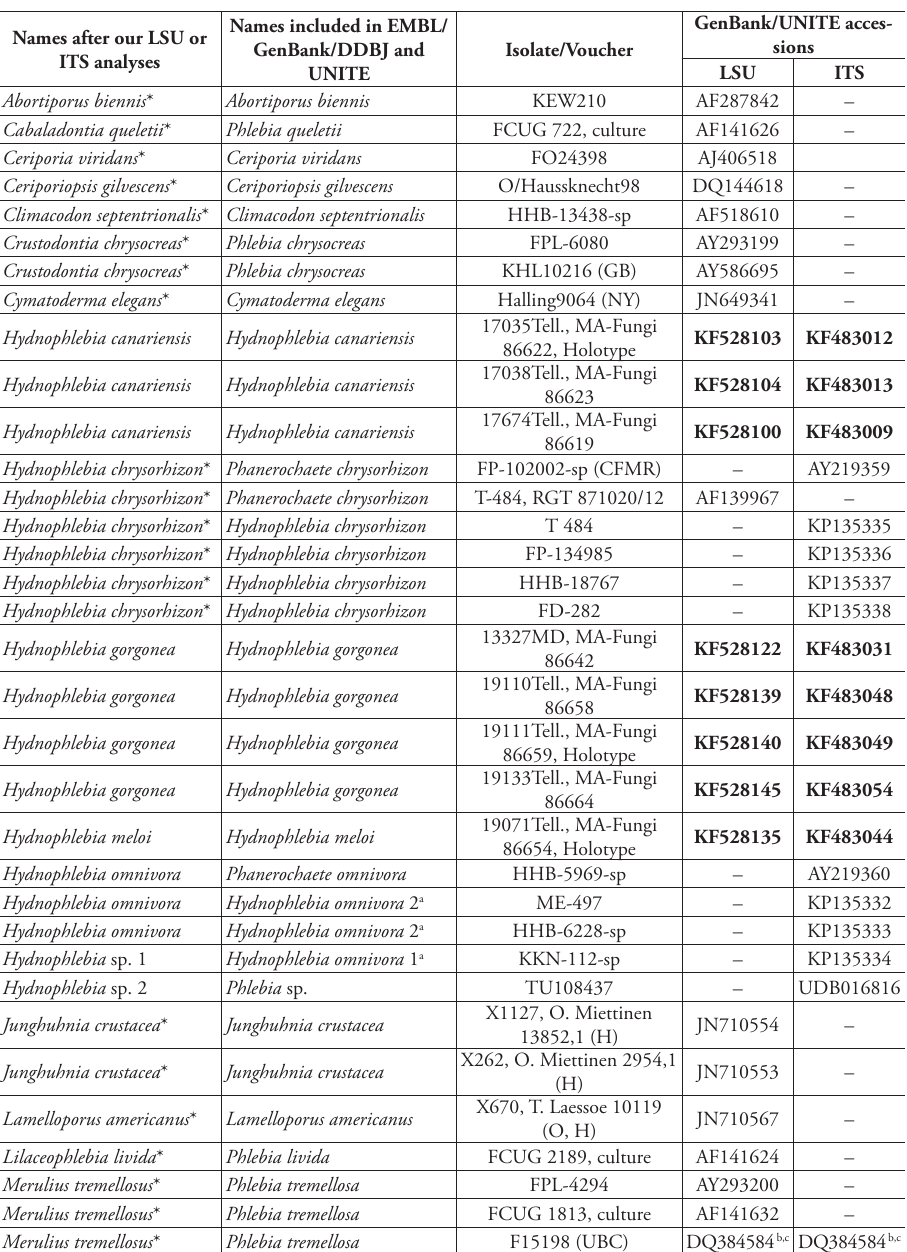
Table 1. Specimens of Hydnophlebia species described as new, and EMBL/GenBank/DDBJ and UNITE accessions included in the LSU and ITS nrDNA analyses. The asterisk (*) after the taxon names denotes type species of the genus. The specimens with uncertain generic placement are listed at the end of the table; in Fig. 1 and 2, the uncertainty is indicated by brackets around the name. Isolates and/or voucher specimens are indicated as they appear in GenBank and UNITE